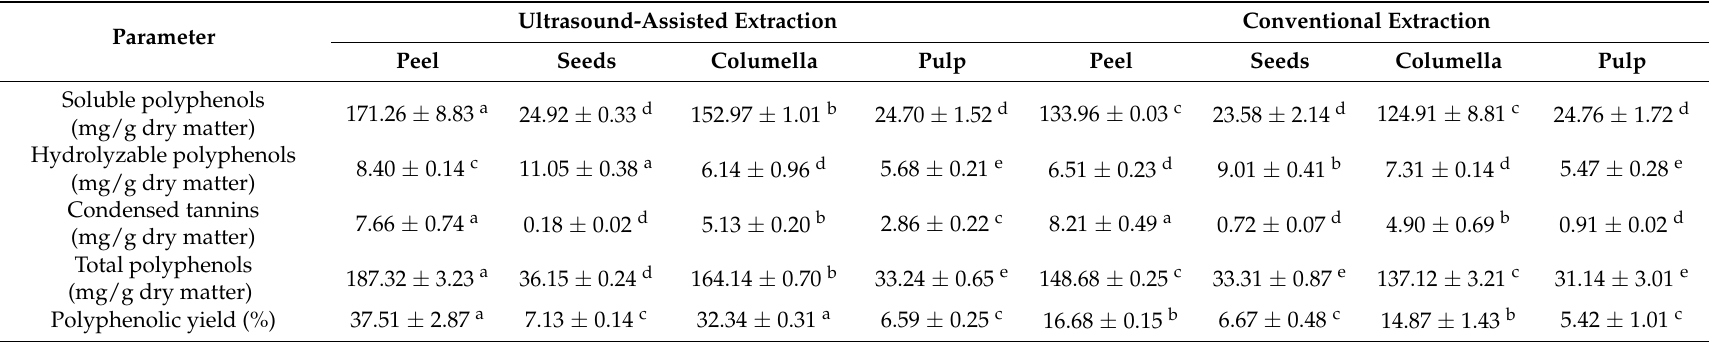
Table 5. Soluble and hydrolyzable polyphenols, condensed tannins, total polyphenols, and yield from Annona muricata peel, seed, columella, and pulp using the optimal conditions for ultrasound-assisted extraction and conventional extraction (extraction for 2 h under stirring, see Section 3.6.1).